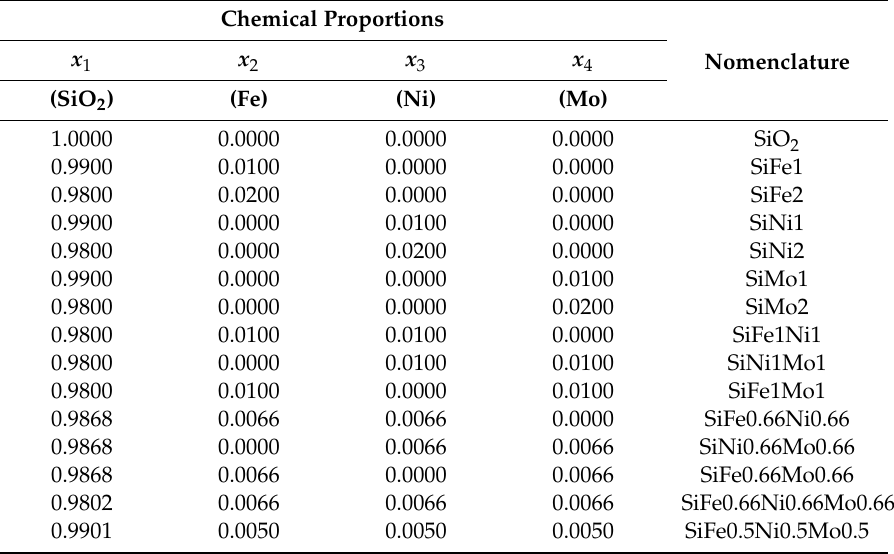
Table 9. Chemical proportions and nomenclature of the points in the